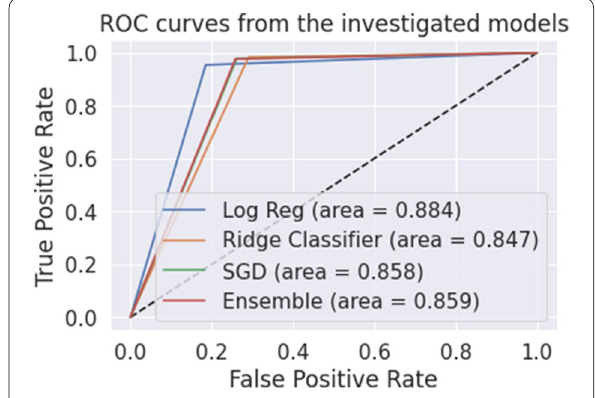
Fig. 3 ROC curve of the Proposed